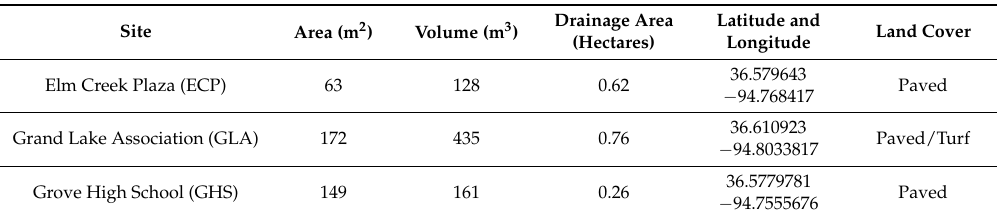
Table 1. Site description, characteristics, and location of three bioretention cells used in the field study in Grove, OK, USA.